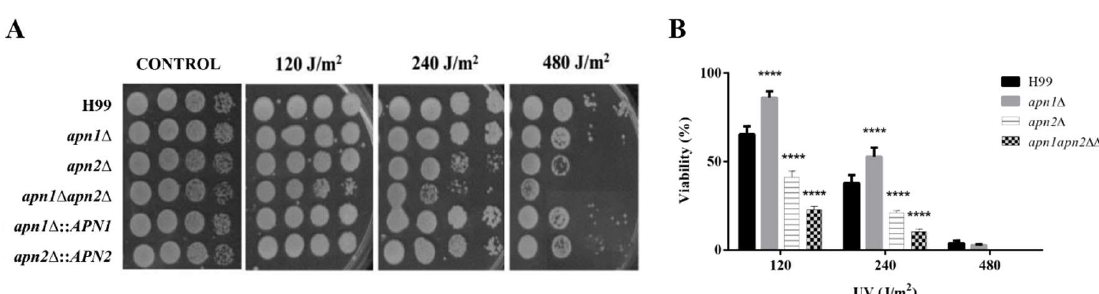
Figure 2. Disruption of Apn1- and Apn2-like genes induced C. neoformans susceptibility to UV radiation. ( A ) Ten-fold serial dilutions of C. neoformans WT, mutant and reconstituted strains of yeasts were exposed to 120, 240 and 480 J/m 2 doses of UV radiation (254 nm) and grown at 30 °C, for 48 h. The results are representative of at least three independent experiments. ( B ) Cell viability (%) after UV irradiation. C. neoformans 5 × 10 2 cells were plated on YPD agar and exposed to UV radiation at 120, 240 and 480 J/m 2 at 254 nm. The plates were incubated at 30 °C for 48 h, protected from light, for colony forming unit (CFU) counting. Graph represents the percentage of viable cells normalized by the percentage of viable control cells. The WT H99 strain was used as control for statistical comparison. One-way analysis of variance (ANOVA) with Dunnett’s post-test was used to compare the means of results from three independent experiments. Error bars represent standard errors of the mean. **** p < 0.0001.